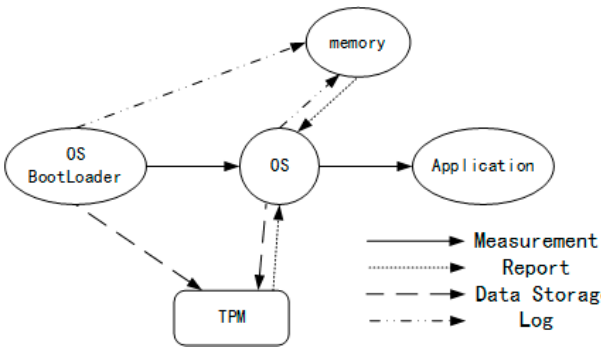
Figure 6. Integrity measurement based on trusted platform module (TPM) and construction of the chain of trust.